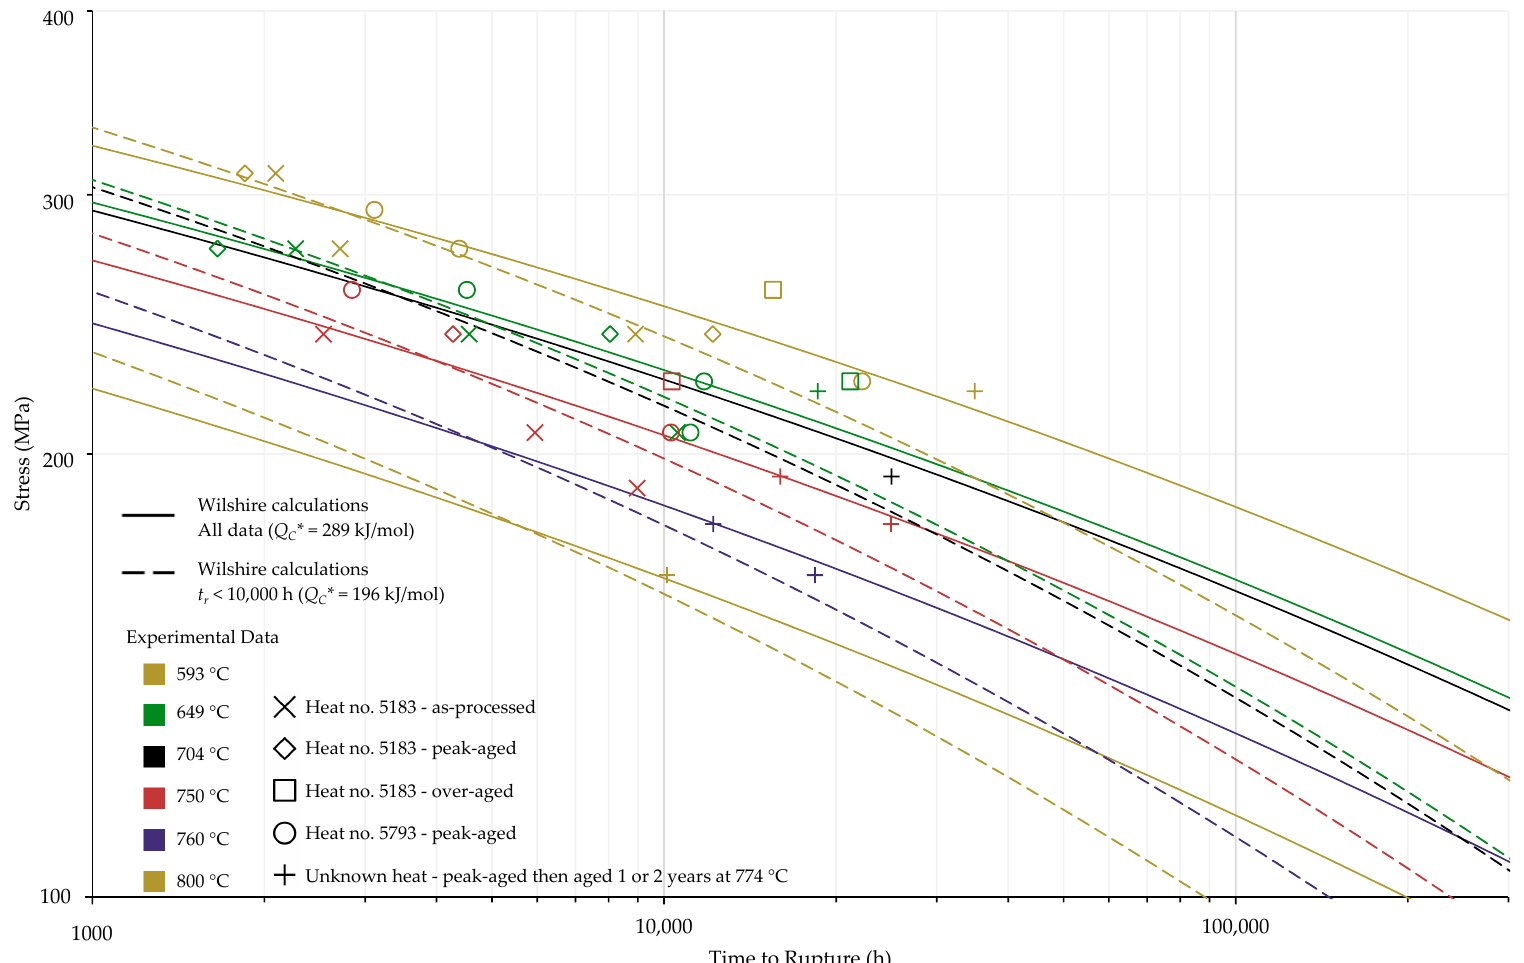
Figure A15. Calculations of the Wilshire equation for Nimonic 105 using average tensile strength values with (cid:1843) (cid:3004)∗ determined by optimizing the correlation of data on a Wilshire plot.